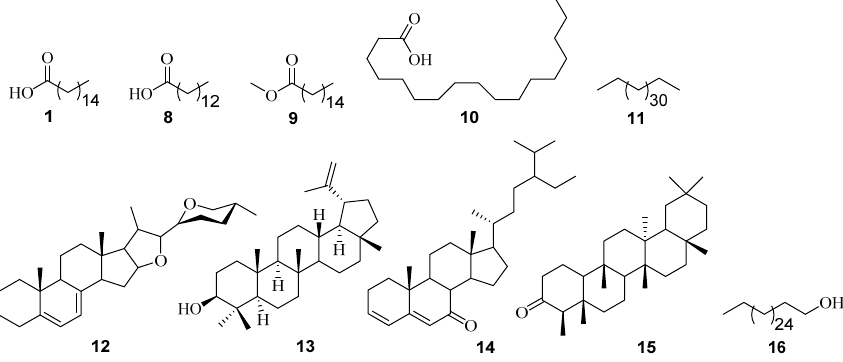
Figure 2. Structures of non-polar constituents identified from P. angolensis using GC-MS analysis.